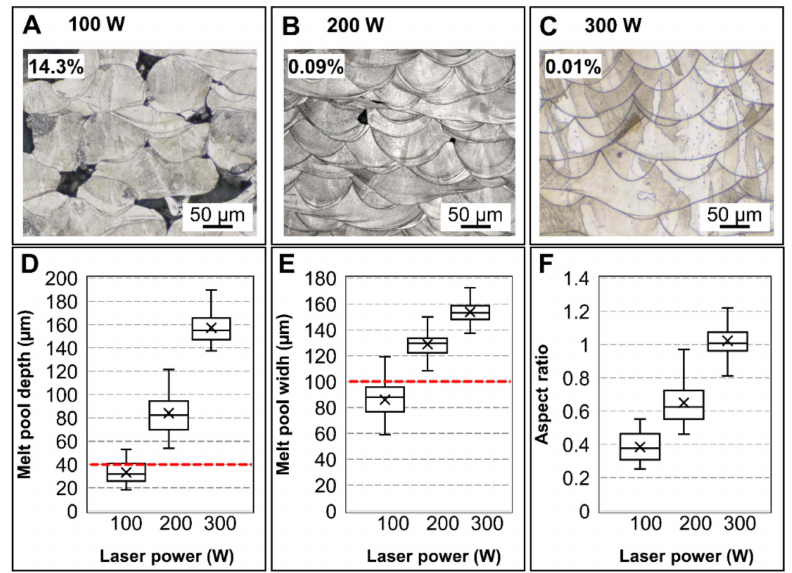
Figure 8. Influence of laser power on melt pool geometries and flaw populations in the conduction regime. Microstructure of specimens manufactured with a laser power of: 100 W ( A ); 200 W ( B ); 300 W ( C ); with otherwise identical parameters (nominal laser scan speed 1000 mm/s and layer thickness 40 µ m). The volume fraction of flaws is indicated. Distribution of melt pool: depths ( D ); widths ( E ); aspect ratios ( F ) for the three levels of laser power. The red dashed lines represent the nominal layer thickness ( D ) and hatch spacing ( E ) used in